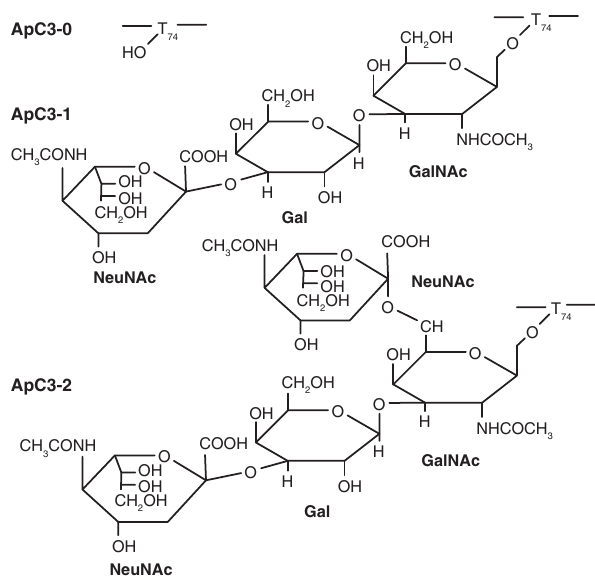
Figure 2 Amino acid sequence of ApoC3 and the structures of dif- ferent glycol-isoforms. Gal, galactose; GalNAc, N -acetyl-galactose; NeuAc, N -acetyl-neuraminic acid. T (Thr) indicates the position for glycosylation (reproduced from Jian et al. 2013, with